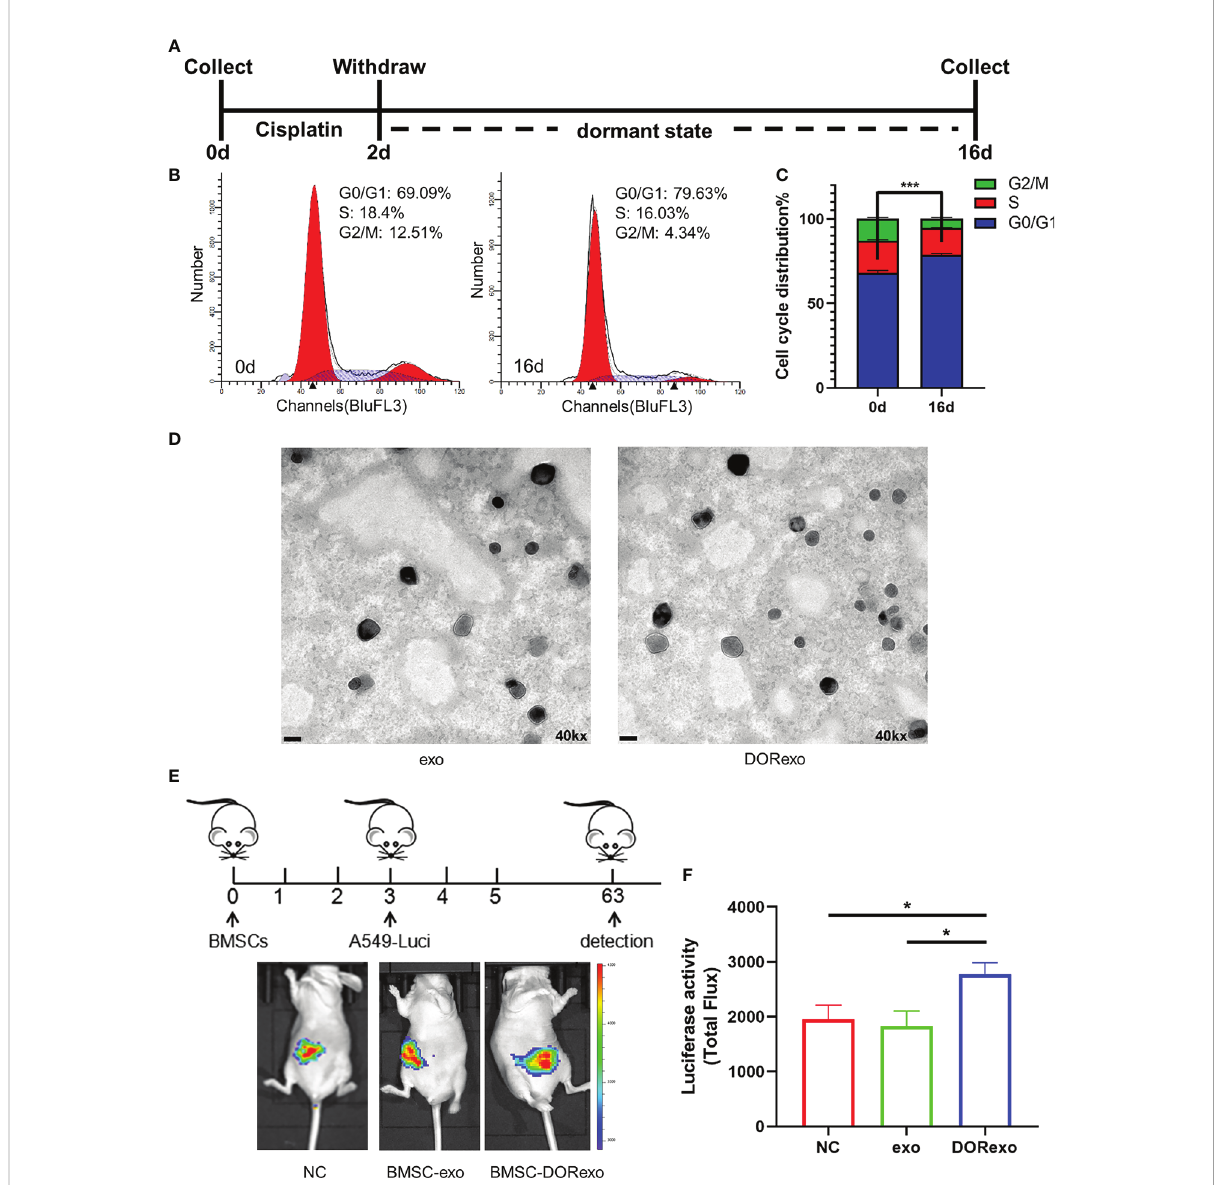
FIGURE 1 Exosomes derived from cisplatin-induced dormant A549 cells promote the growth and metastasis of cancer cells in the bone marrow. (A) Schematic diagram of the cisplatin treatment experiment. A549 cells were treated with cisplatin for 2 days. The remaining cells after treatment were cultured for an additional 14 days. (B) Cell cycle analysis of cisplatin-treated A549 cells. (C) The ratio of cells with different cell cycles was represented in the histogram graph. G0 – G1 phase, ***P < 0.001. (D) Transmission electron microscopy images of exosomes isolated from cancer cells. exo, exosomes from untreated A549 cells; DORexo, exosomes from dormant A549 cells. Scale bar: 100 nm. Magni fi cation: ×40,000. (E) Schematic diagram of animal experiments. BMSCs that were incubated with exosomes were injected into the bone marrow cavity, and A549-luciferase cells were injected into the bone marrow cavity 3 days later. The growth and metastasis A549 were evaluated by bioluminescence. All mice were intramedullary injected with luciferase-labeled A549 cells. Animal imaging fl uorescence images: the imaging image on 63 days after A549-luciferase cells ’ injection. NC, mice without BMSC injection; BMSC-exo, mice with injection of exo-treated BMSCs; BMSC-DORexo, mice with injection of DORexo-treated BMSCs. (F) The activities of luciferase were shown in the histogram. *P <